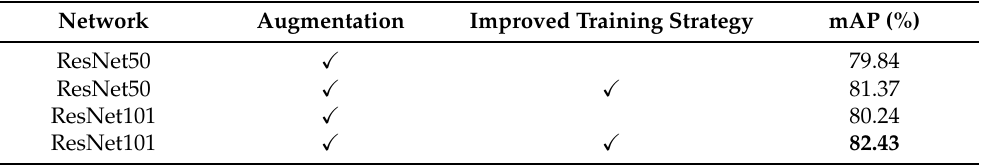
Figure 5. Visualization of the final augmentations selected for the dataset. ( a ) Original, ( b ) rotated, ( c ) sharpened, ( d ) enhanced color, ( e ) edge detect. Table 7. Final results on ResNet50 and ResNet101 with updated learning rate